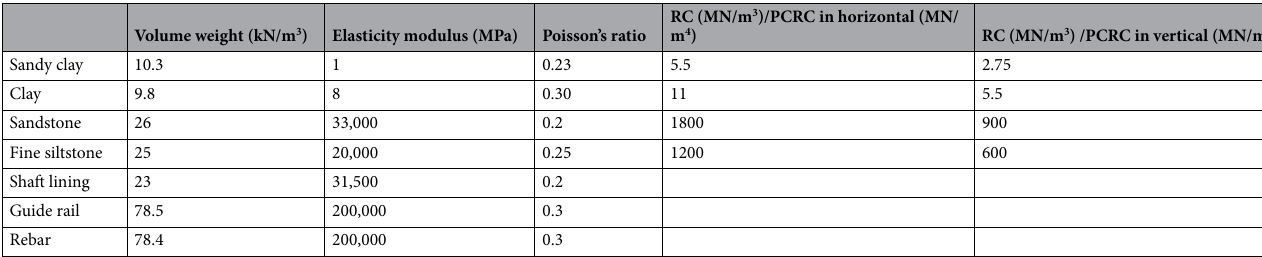
Table 1. Basic parameters of finite element model.